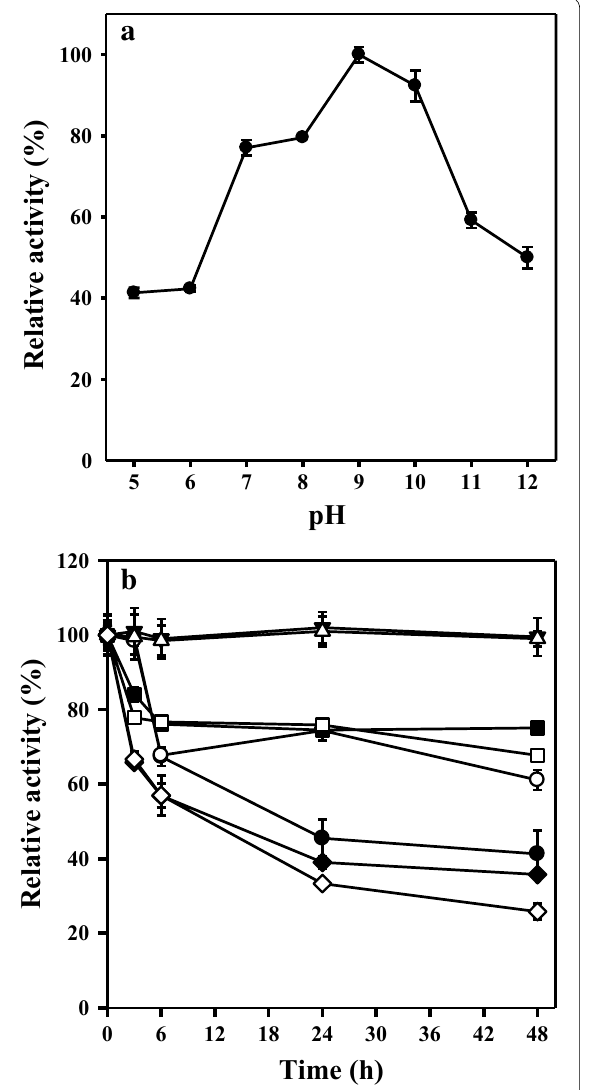
Fig. 2 a Effect of temperature on KerP activity. b Temperature stabil‑ ity of KerP. Enzyme activity was preserved at various temperatures between 0 and 60 min before assaying enzyme activity. 30 °C (filled circle), 40 °C (open circle), 50 °C (filled inverted triangle), 60 °C (open triangle), and 70 °C (filled square) for 60 min. The enzyme activity was assayed with feather powders as the substrate at pH 9.0 for 1